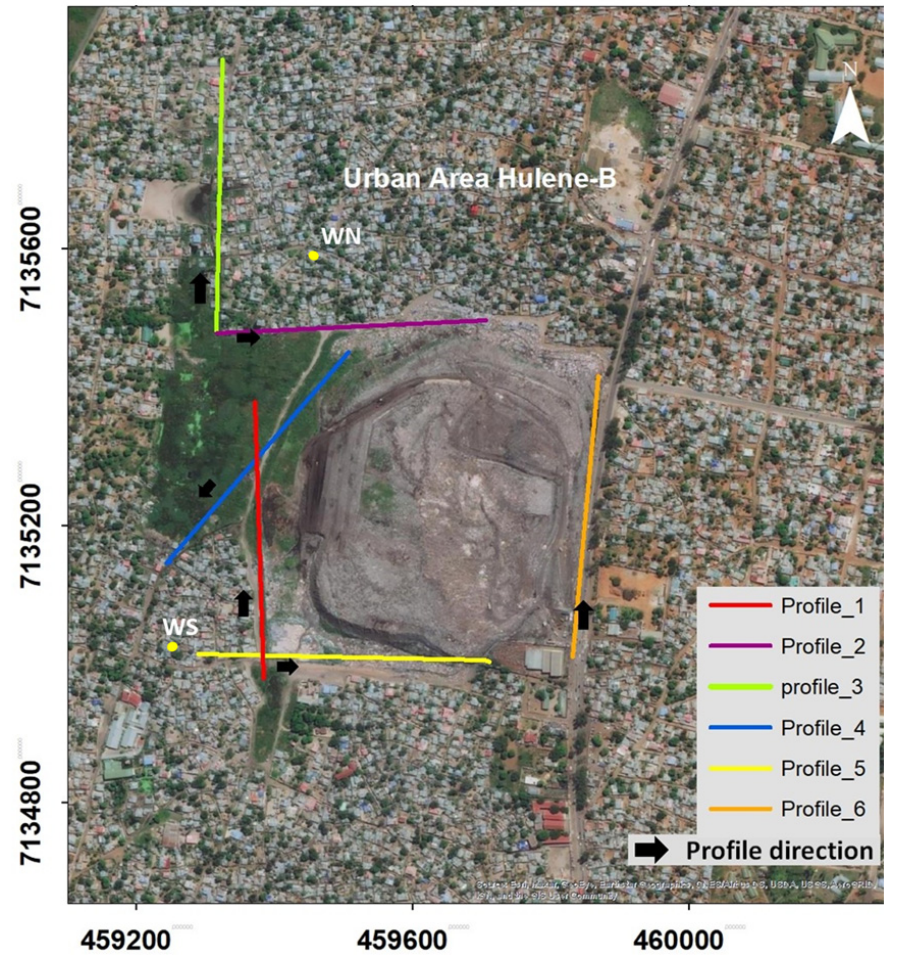
Figure 3. Electrical resistivity profiles and northern (WN) and southern (WS) wells studied, in the surroundings of the Hulene ‐ B waste dump.